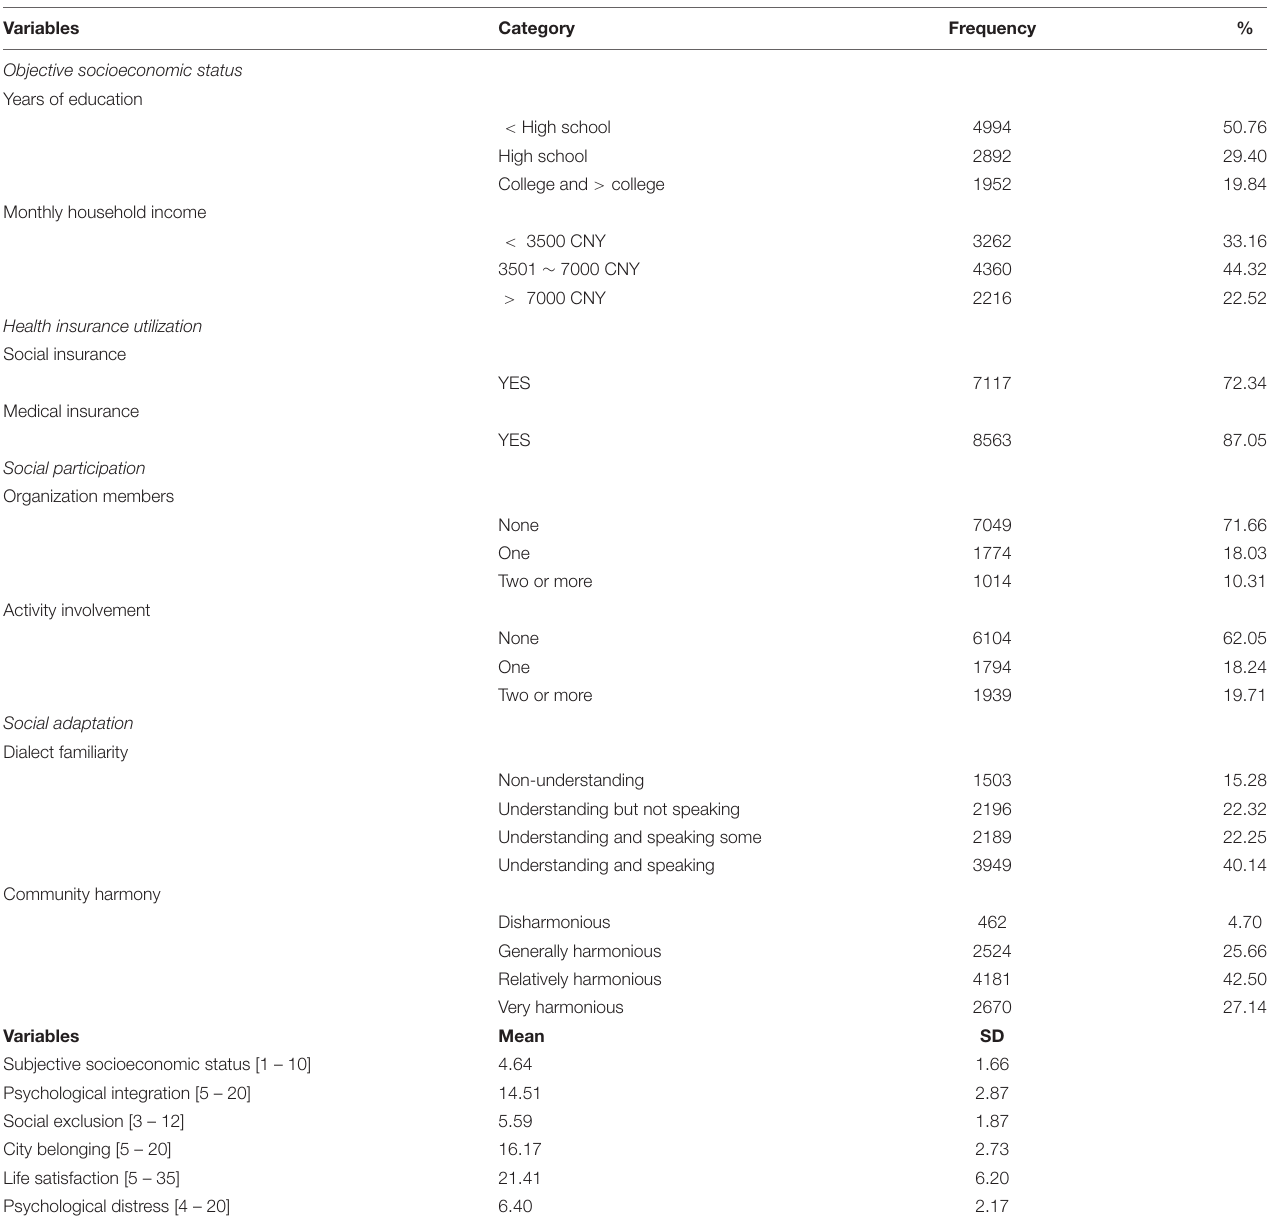
TABLE 2 | Descriptive data in the final structural equation